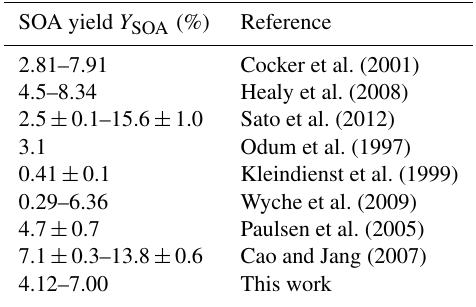
Table 4. SOA yields ( Y SOA ) of 1,3,5-TMB reported in the literature. SOA yield Y SOA ( %